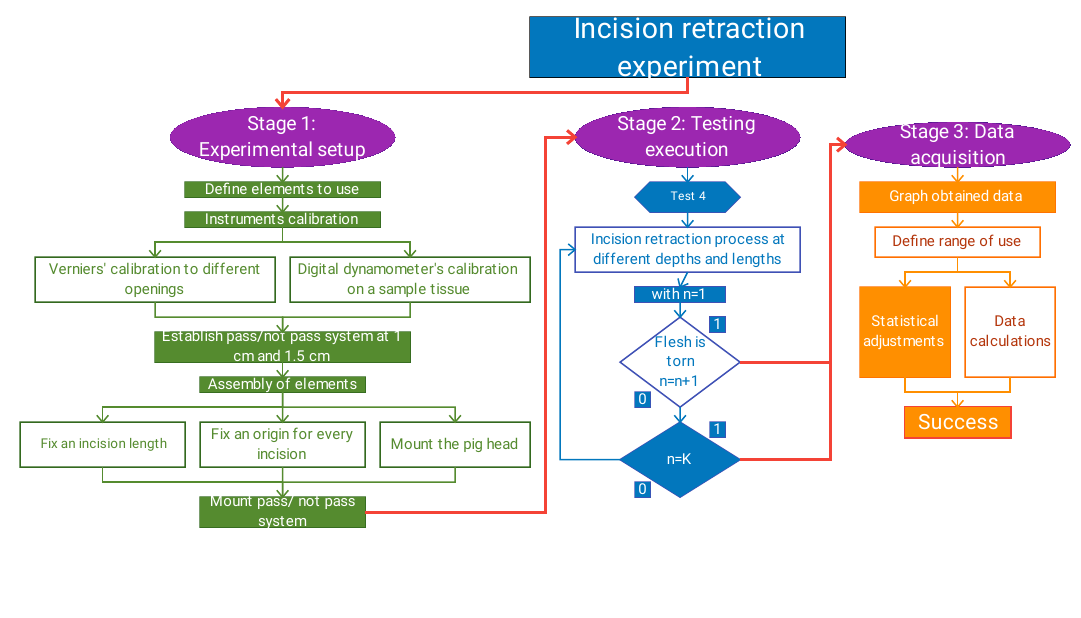
Figure 3. Experimental